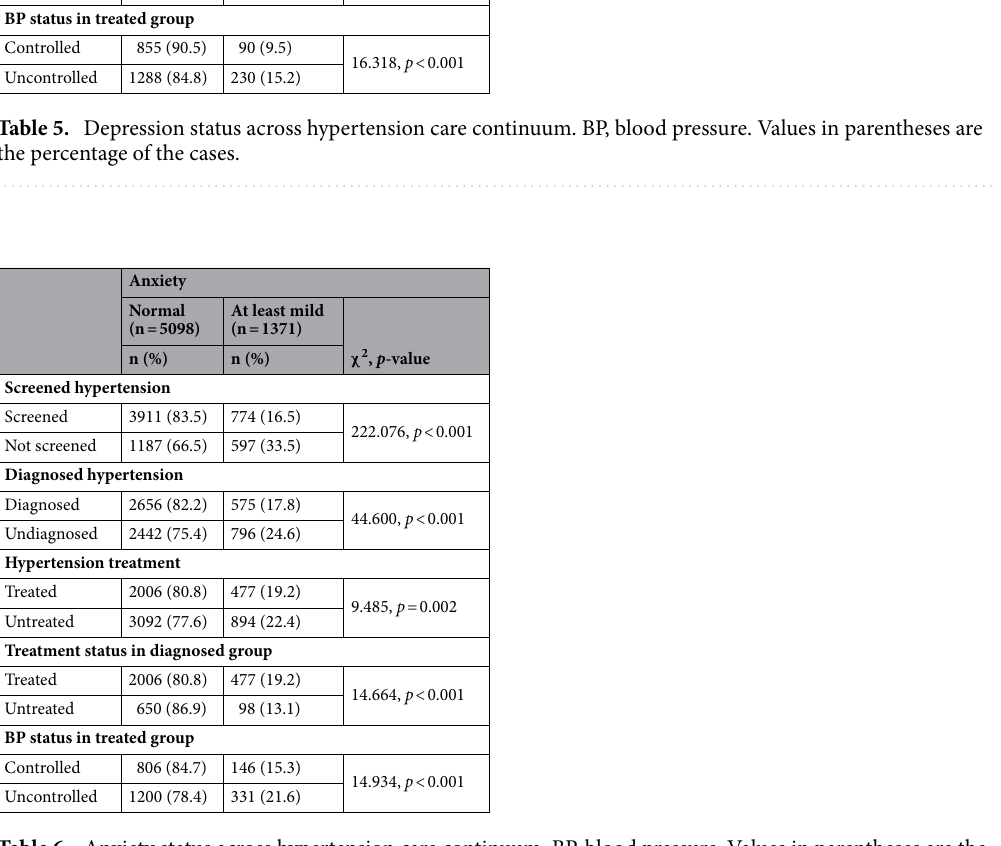
Table 6. Anxiety status across hypertension care continuum. BP, blood pressure. Values in parentheses are the percentage of the